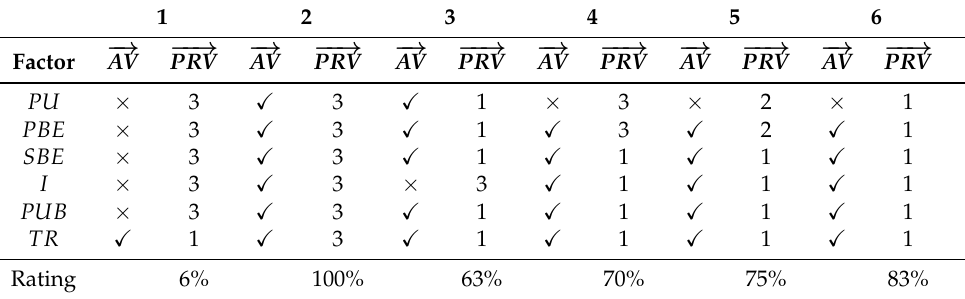
Table 3. Overview of different acceptance scenarios for edge